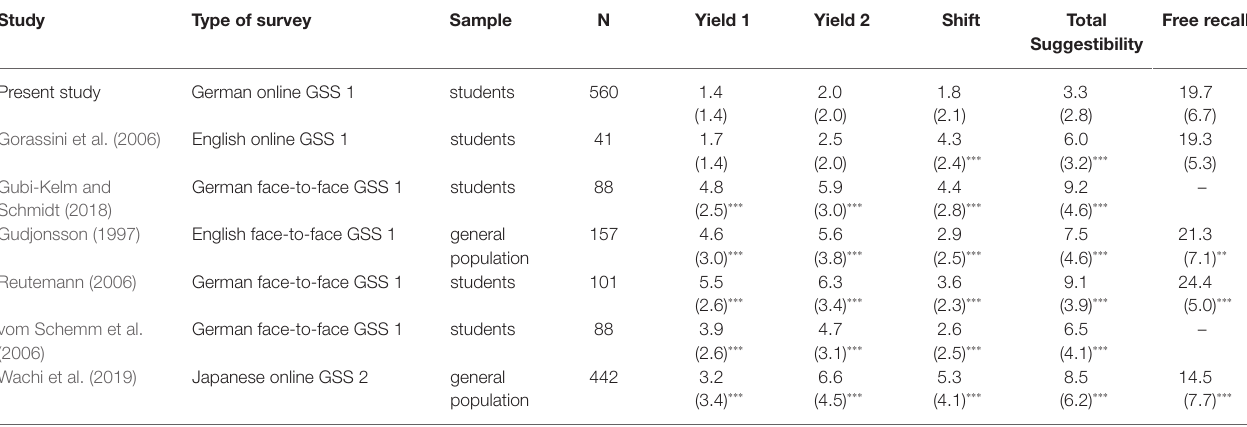
TABLE 3 | Comparison of means and standard deviations of the suggestibility scores measured by GSS in different